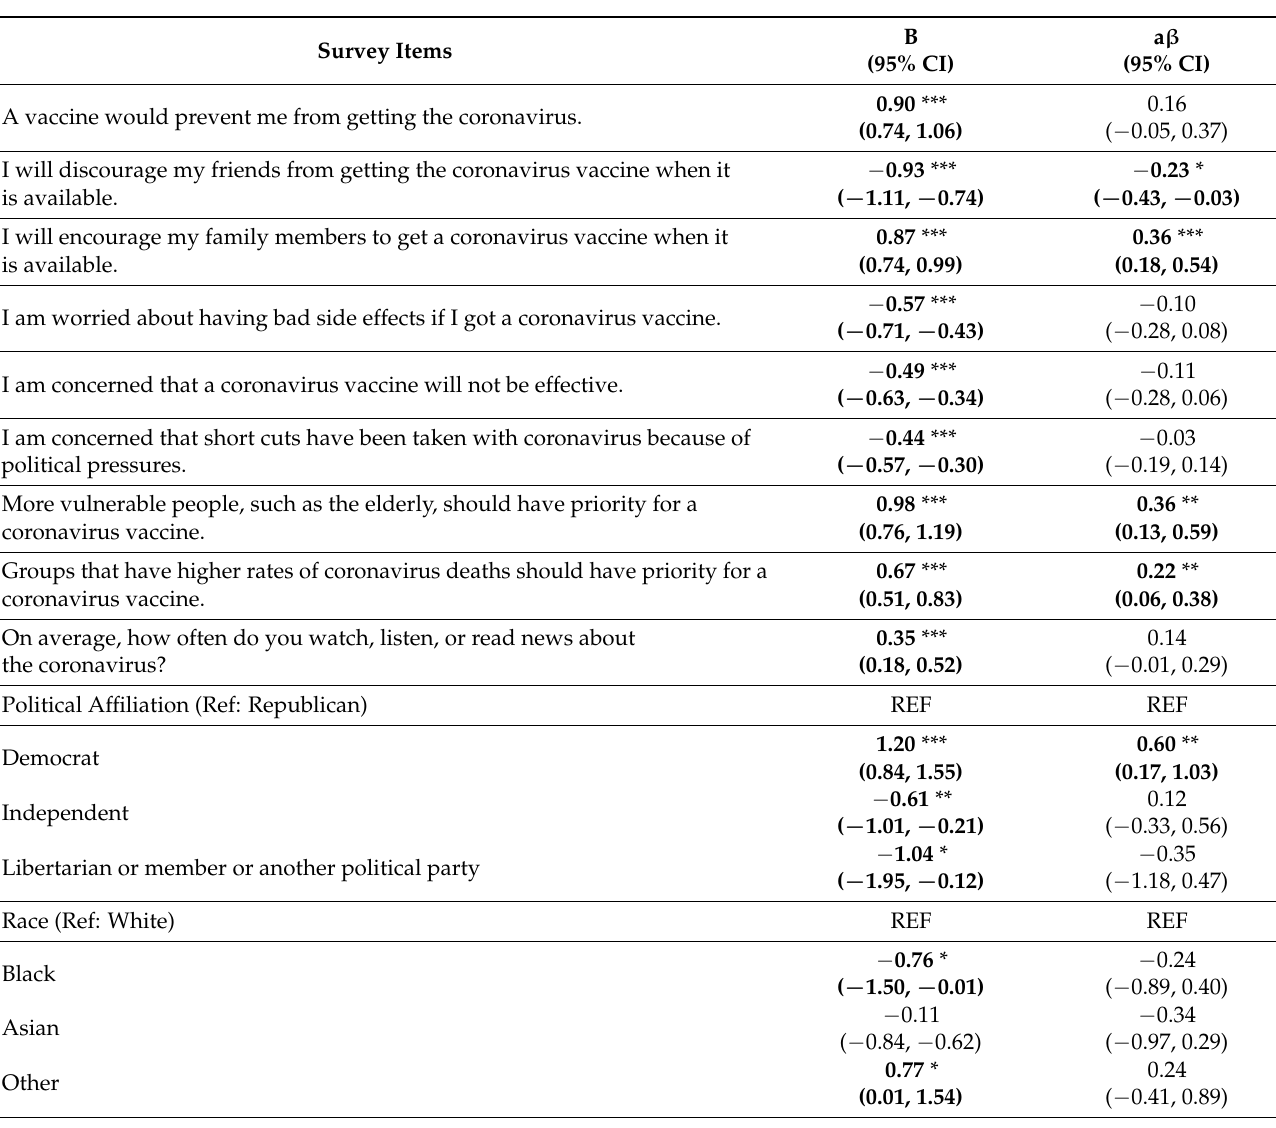
Table 7. Multiple linear regression with continuous 8-item MS vaccine trust measure as the dependent variable (range